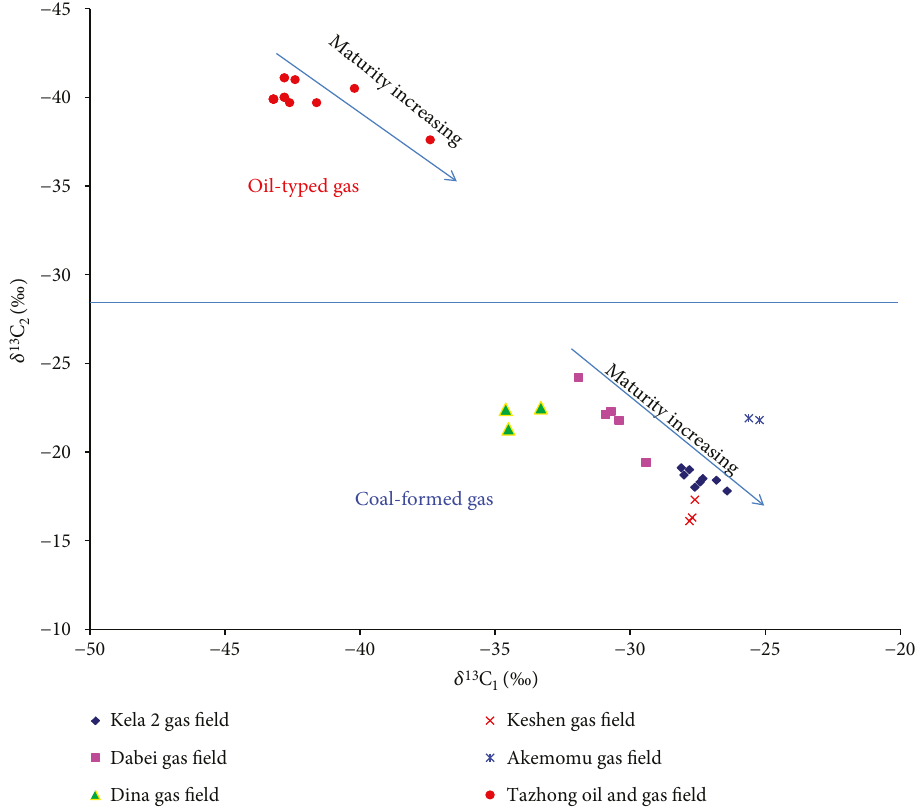
Figure 4: Genetic identi fi cation of δ 13 C Basin (modi fi ed from [25,